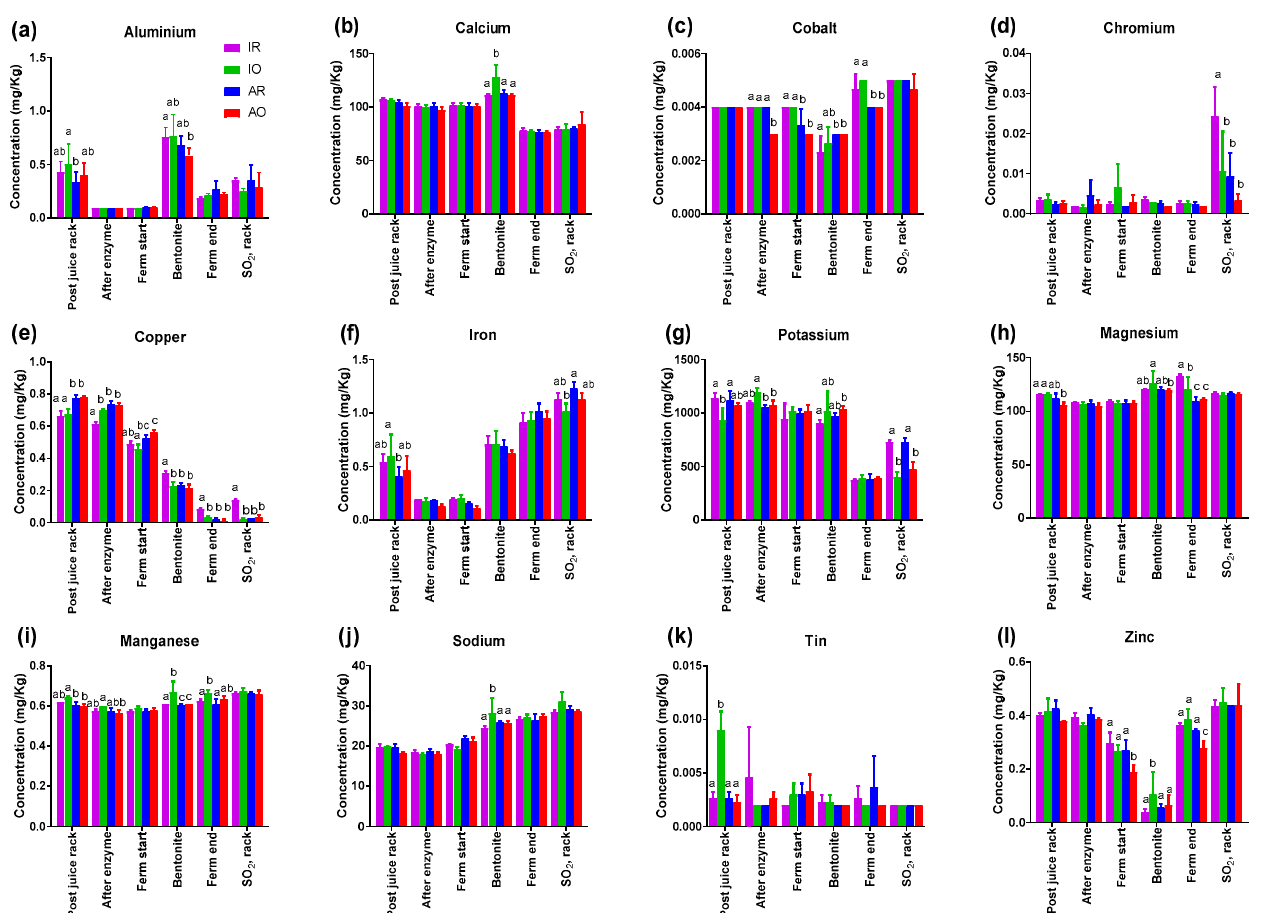
Figure 4. Effects of oxygen exposure during pressing and handling on the concentration of Al ( a ), Ca ( b ), Co ( c ), Cr ( d ), Cu ( e ), Fe ( f ), K ( g ), Mg ( h ), Mn ( i ), Na ( j ), Sn ( k ) and Zn ( l ) in Chardonnay wines during the fermenting stage for inert pressing–reductive handling (IR, purple), inert pressing–oxidative handling (IO, green), aerobic pressing–reductive handling (AR, blue), and aerobic pressing–oxidative handling (AO, red) treatments. Significant differences between treatments are indicated by different letters above each bar graph as determined by ANOVA.